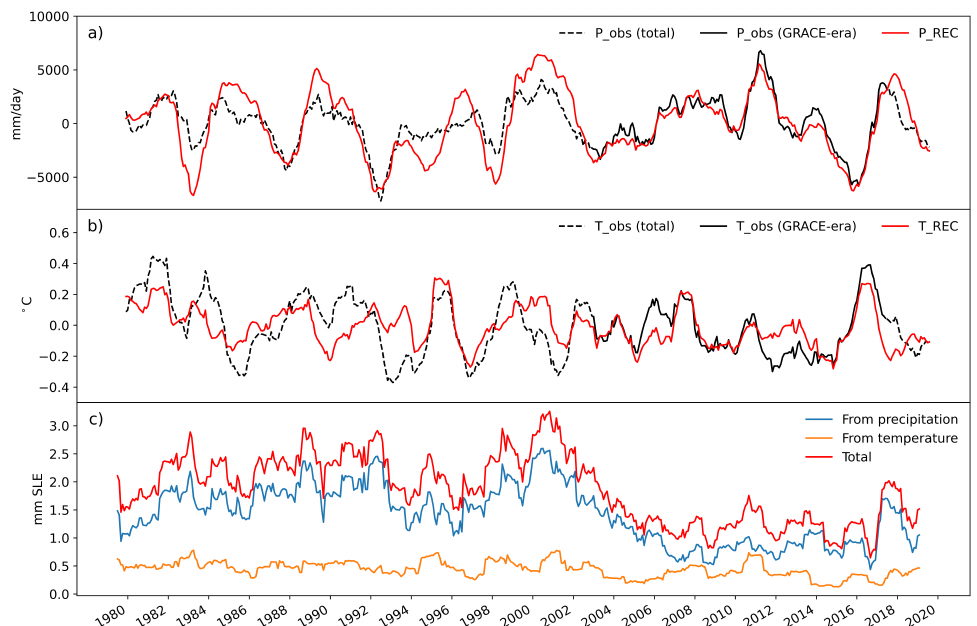
Figure 1. Time series of global terrestrial precipitation ( a ) and 2 m air temperature ( b ) along with their reconstructions (P_REC and T_REC, respectively), and the uncertainty of the reconstructed global TWS (TWS_CSEOF) based on precipitation and temperature ( c